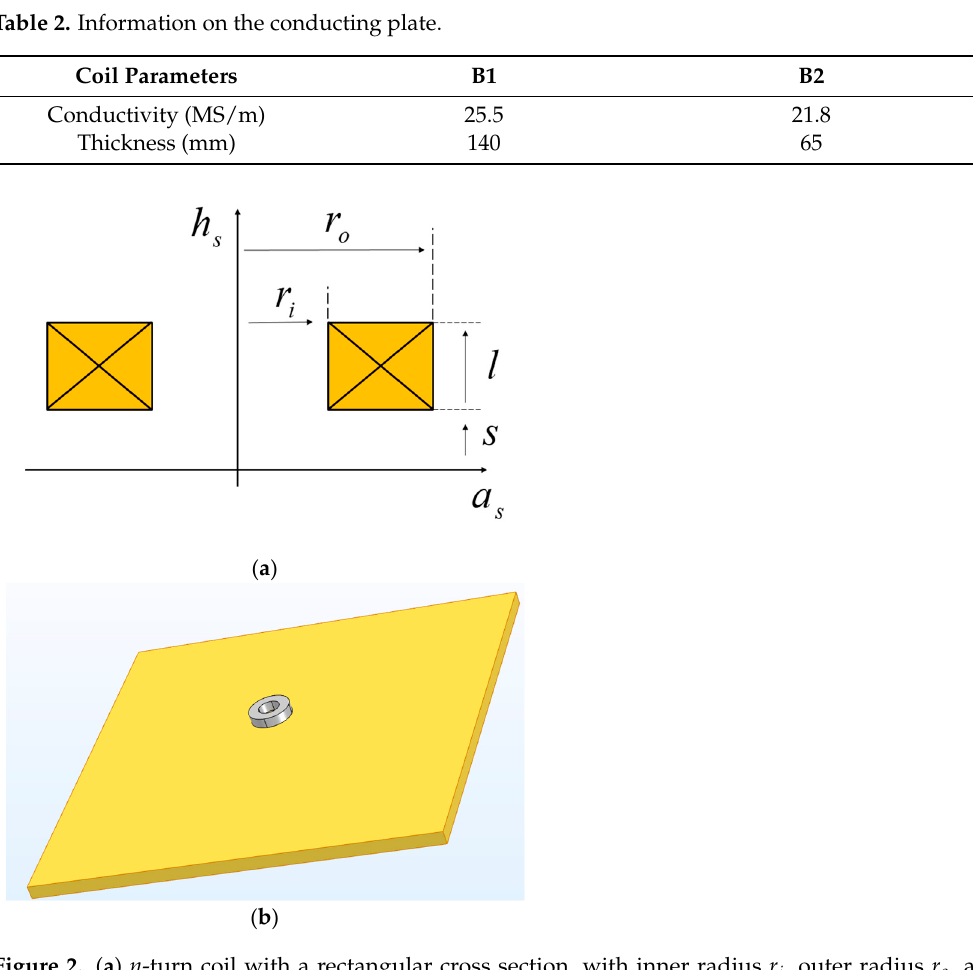
Figure 2. ( a ) n -turn coil with a rectangular cross section, with inner radius r i , outer radius r o , a thickness l , and lift-off distance S . ( b ) placing the coil with rectangular cross section above the object under detection.